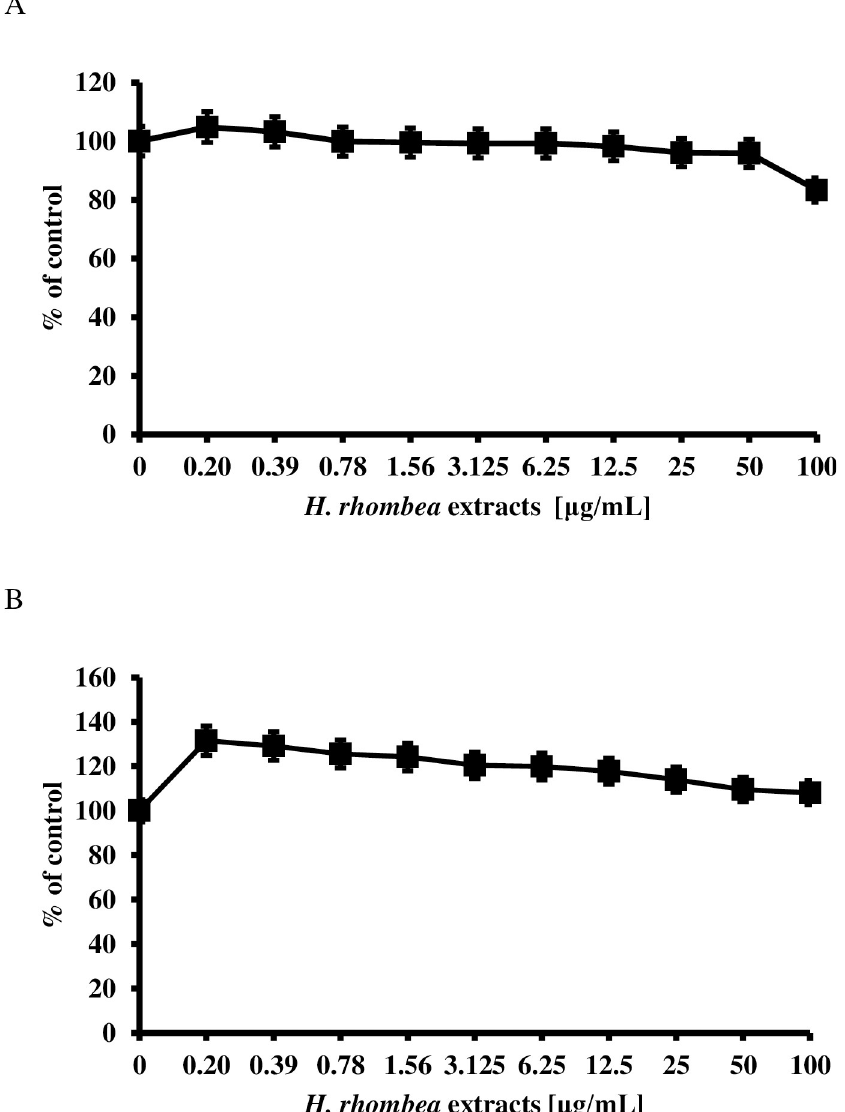
Fig 6. H . rhombea extract did not show any toxicity against the human skin cells. Cytotoxicity of H . rhombea extract against HaCaT cells (A) and THP-1 cells (B). Each cell (10 4 per well) was incubated with the indicated concentration of H . rhombea extract in 96-well for 24 h and the cell viability was evaluated by MTT assay.